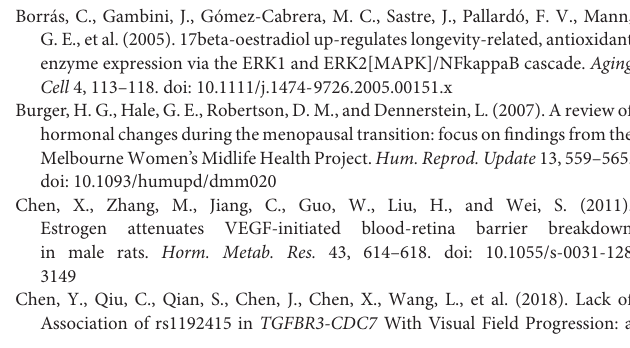
Supplementary Figure 1 | (A–H) Spearman analysis for correlation between blood levels of sex hormone and ocular parameters. In the Scatter plot, every plot means a subject. PRL, prolactin; LH, luteinizing hormone; TESTO, testosterone; FSH, follicle-stimulating hormone; PROG, progesterone; E2, 17- β -estradiol; IOP, intraocular pressure; ACD, anterior chamber depth; MD, mean